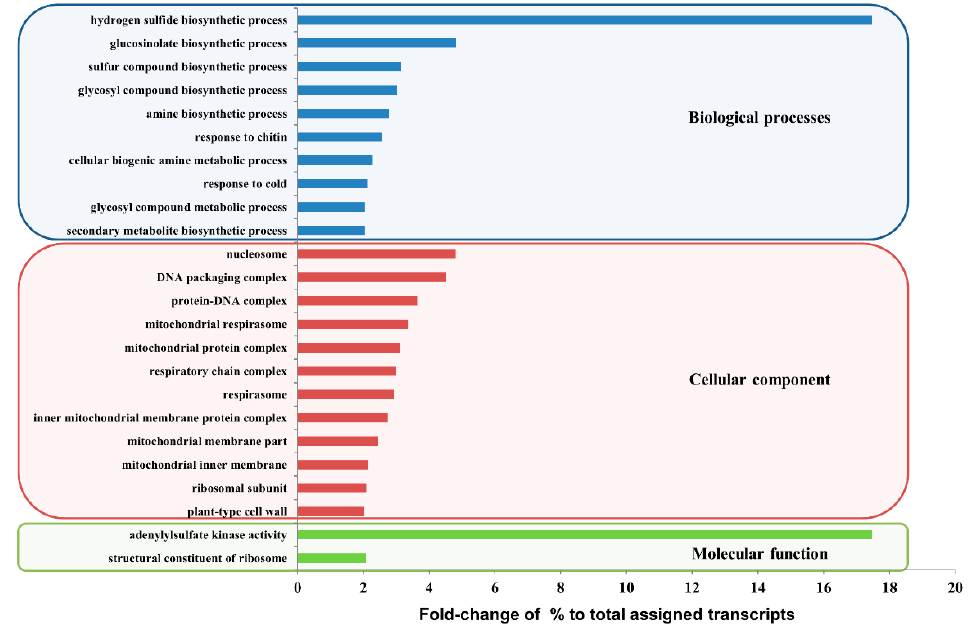
Figure 3. Functional classification of the gene ontology (GO) of DEGs between the HGRHA and LGRHA roots. Up-regulated genes in the HGRHA roots, when compared with the LGRHA roots, were divided into three main categories (biological processes, cellular component, and molecular function). The GSL biosynthetic process ranked second in the biological processes category. All GO terms were filtered by the following values; p -value < 0.01, false discovery rate < 0.01, fold-change of selected genes to total genes > 2. The x -axis indicates the fold-change as a% of total assigned transcripts. Detailed information is listed in Table S4.